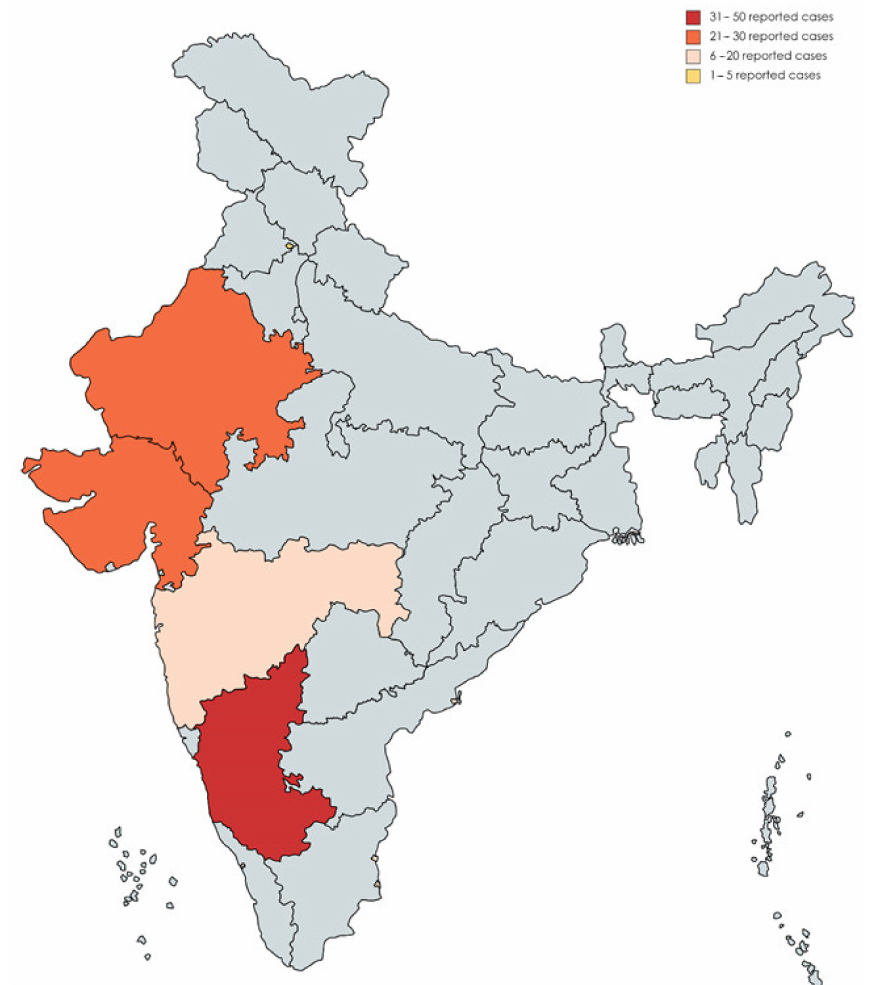
Figure 5. Geographic Distribution of COVID-19-associated Mucormycosis (CAM) Reported Cases in the Republic of